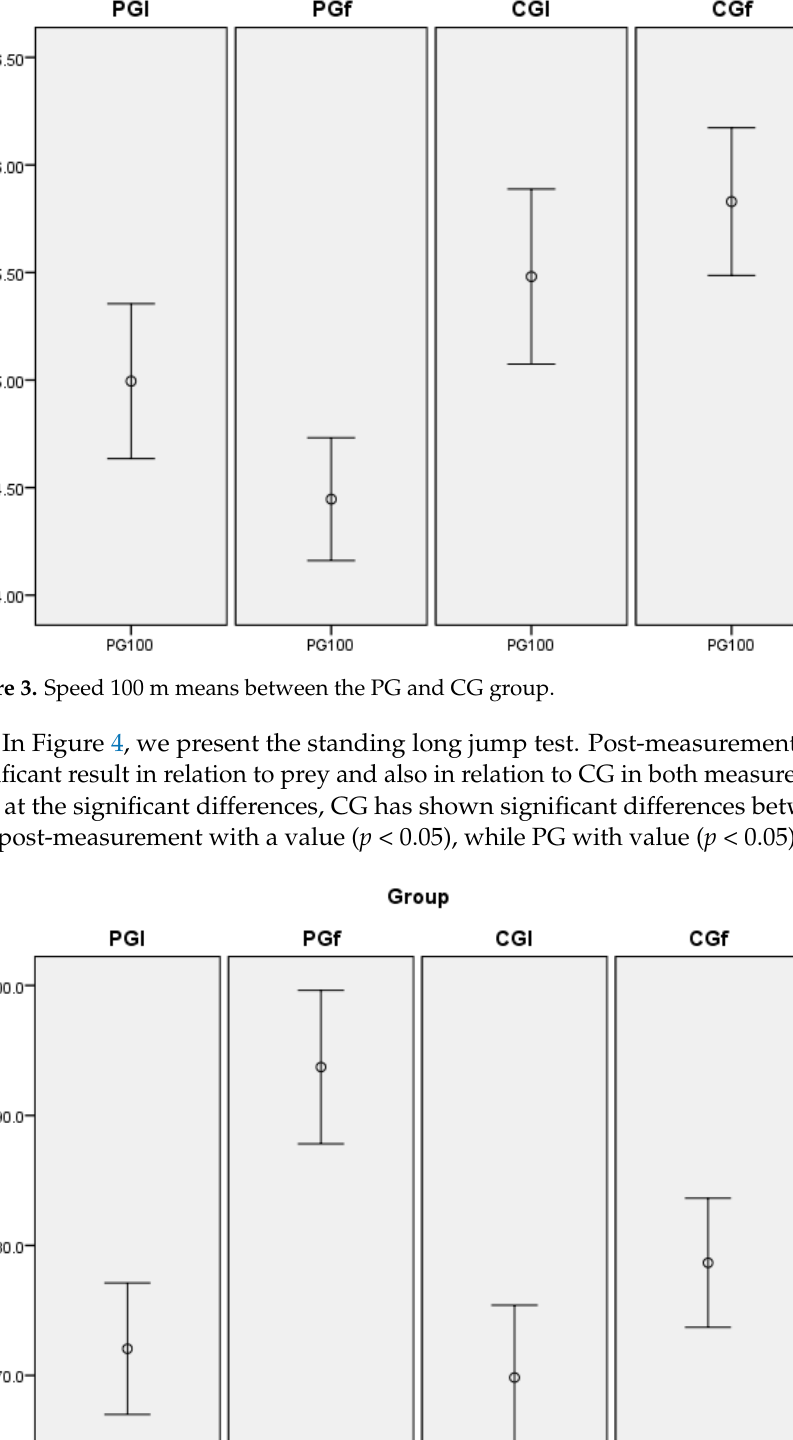
Figure 5. Standing triple jump means between the PG and CG group. In Figure 6, we have presented the vertical jump test; in this case, we see that PG has better results in the post-measurement in relation to the pre-measurement. If we take the ratio between the PG and CG group, we see that the post-measurement has a significant difference between the measurements in the two groups. In CG, significant differences were presented between pre and post with a value ( p < 0.05), and differences were also